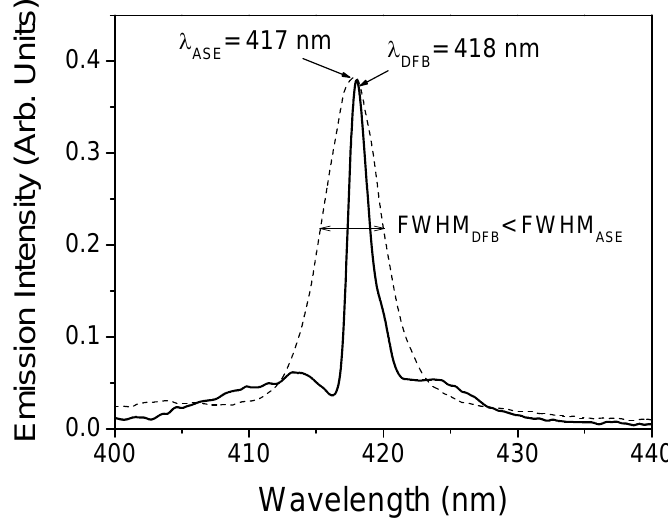
Figure 9. DFB emission of a TPD-doped PS film deposited over glass with a DFB grating (full line) and ASE emission of a similar film over a bare glass substrate without grating (dashed